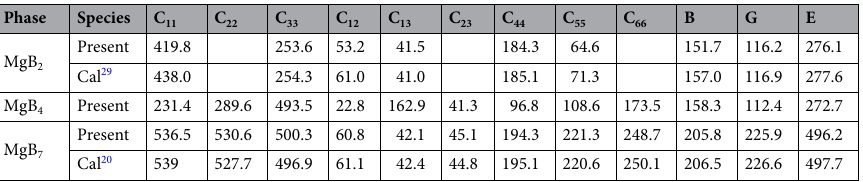
Table 2. Elastic constants C ij (GPa) and elastic moduli B, G, and E (GPa) of Mg–B compounds at 0 GPa along with the reported data.